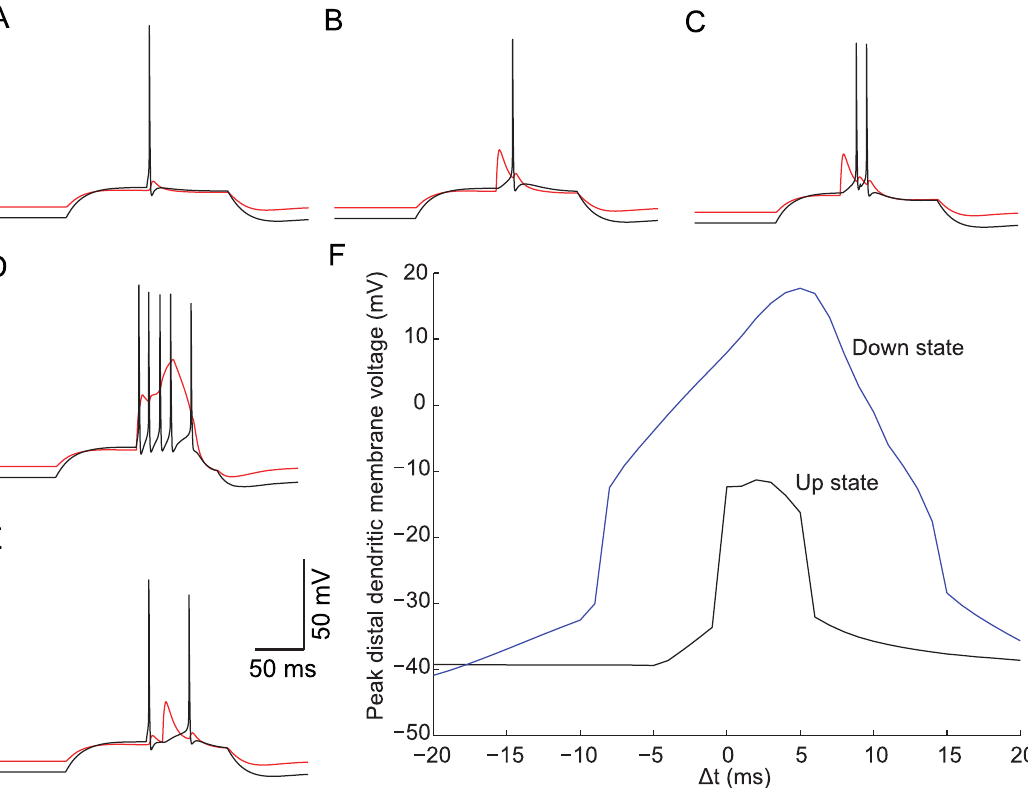
Figure 8. Enhanced gain and temporal sensitivity in BAC firing in Up state. Subthreshold DC depolarizing current of 0.42 nA was injected to the model shown in Figure 4, 200 m m from the soma, to emulate the Up state. Black–recording at the soma, red–recording at the apical dendrite, 700 m m from the soma. A. Model response to a brief, 5 ms 0.5 nA, step current pulse to the soma, resulting in a single AP. B. Model response when an EPSP-like current (0.5 nA) is injected in the main apical bifurcation, resulting in a single Na + AP in the soma. C–E. Model response when the somatic and dendritic inputs coincide with time difference ( D t) of 2 20 msec ( C ), 0 msec ( D ) and + 20 msec ( E ). Note that when the two inputs are applied with D t of 0 ( D ), a Ca 2 + spike is generated in the dendrite, along with a burst of five perisomatic Na + APs. F. Peak dendritic voltage at the distal dendrite recording site as a function of D t during an Up state (black) or Down state (when no DC current is applied, blue). Note the narrower time window for Ca 2 + spike generation in an Up